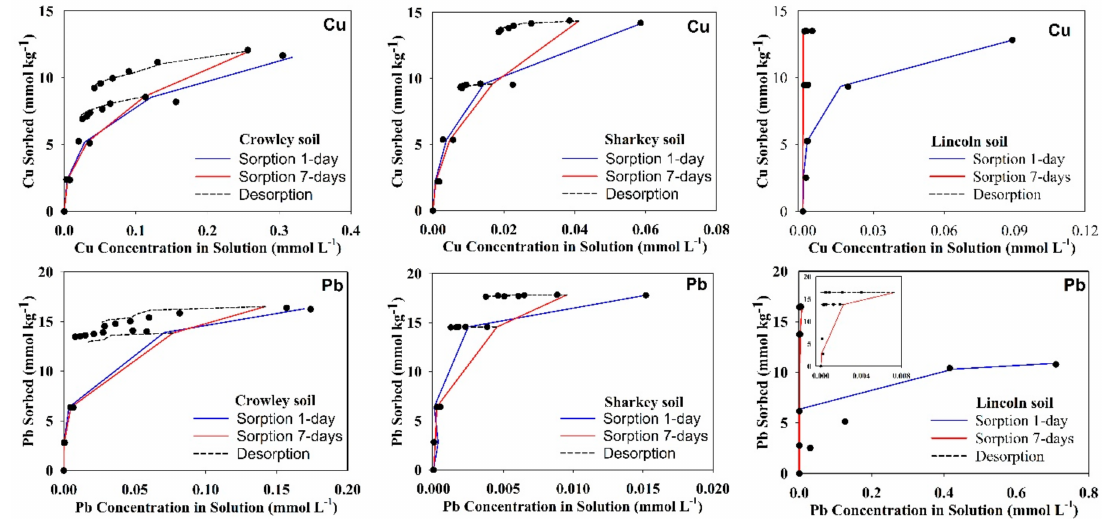
Figure 4. Hysteresis of Cu and Pb sorption / desorption on di ff erent studied soils. Curves represent multireaction model